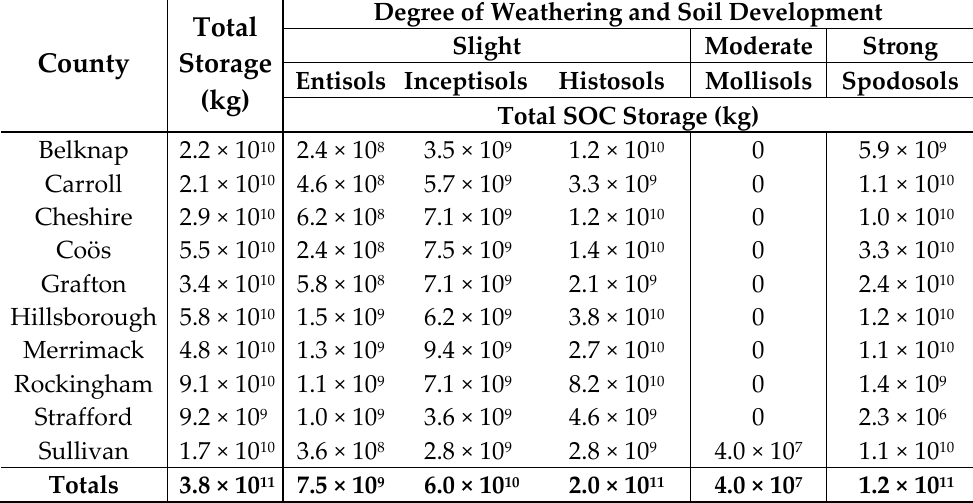
Table 5. Midpoint soil organic carbon (SOC) storage by soil order and county for the state of New Hampshire (USA), based on the areas shown in Table 3 and the midpoint SOC contents shown in Table 4.